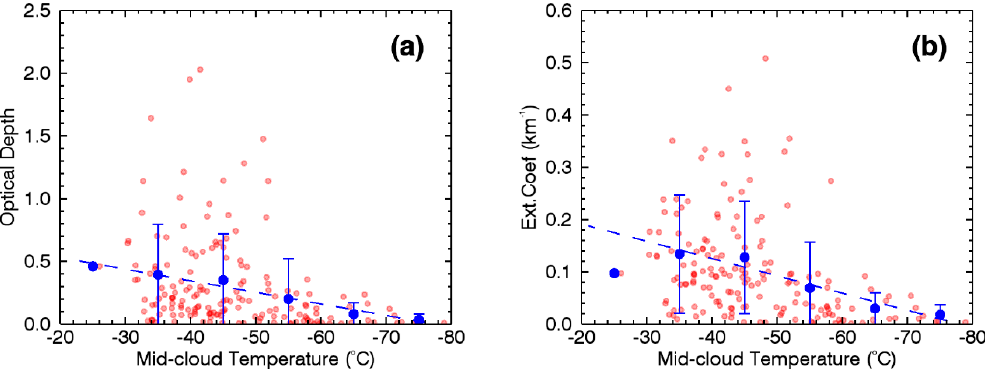
Figure 8. Scatterplots (red dots) showing the relationships between ( a ) cirrus optical depth and mid-cloud temperature, and ( b ) layer-mean extinction coefficient and mid-cloud temperature. Blue dots and vertical bars are the associated mean values and standard derivation grouped every 10 °C. Note that the COD tended to decrease with the lowering mid-cloud temperature.